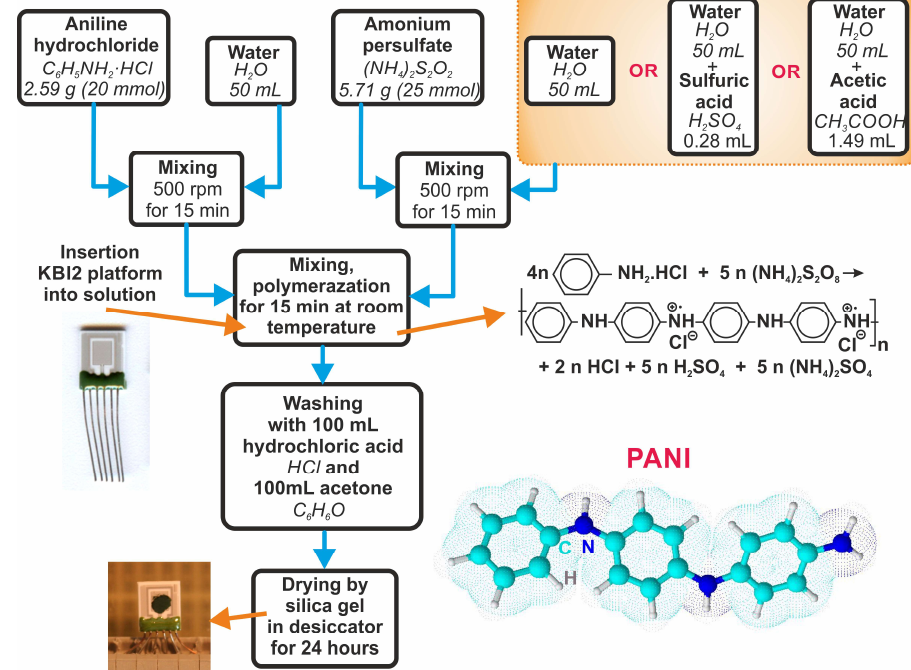
Figure 3. Preparation of various forms of polyaniline.